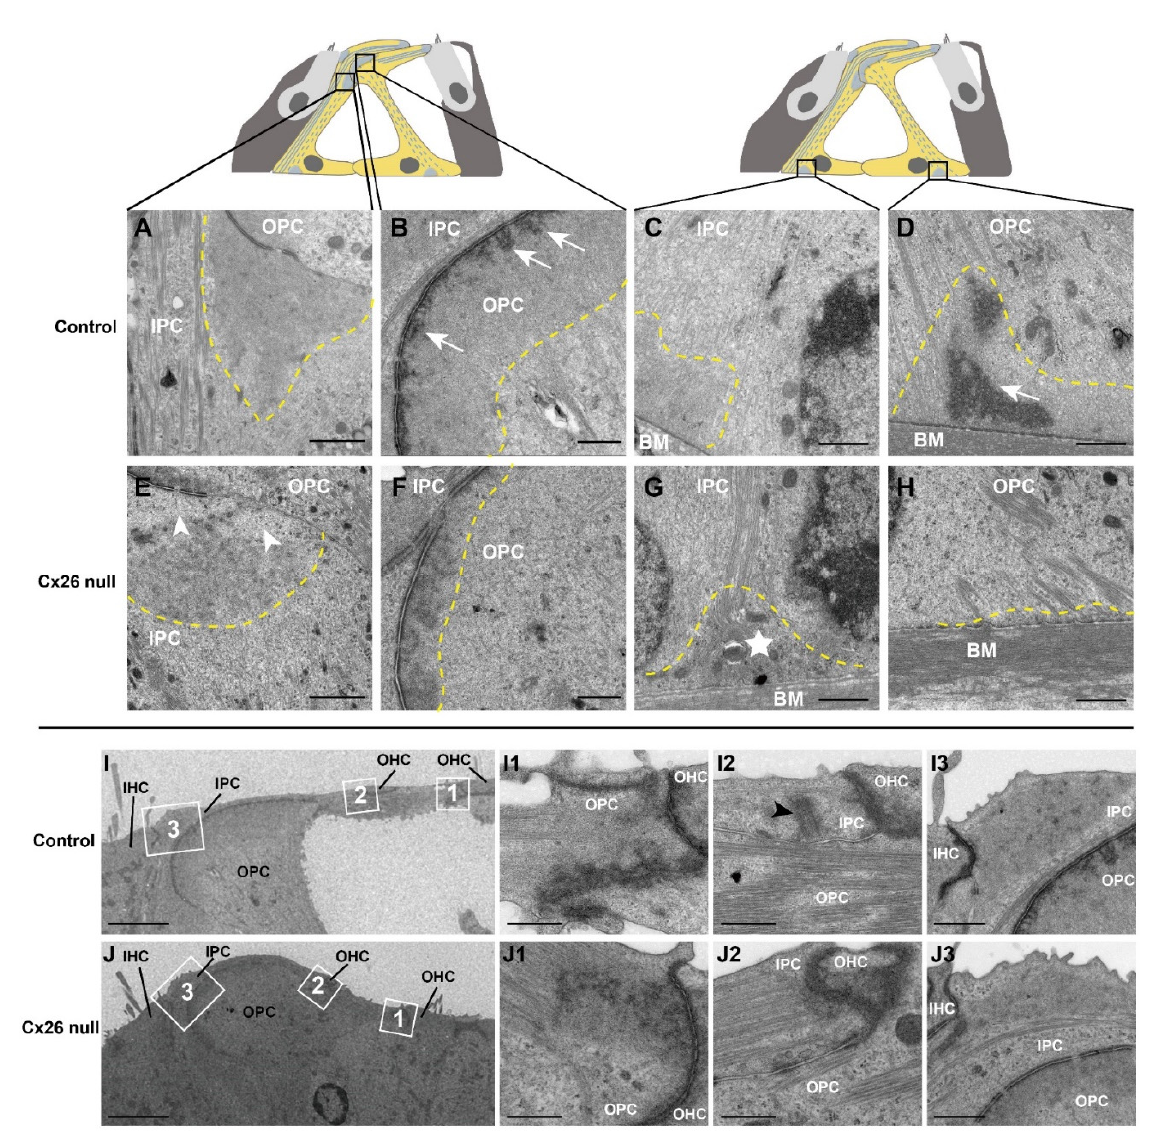
Figure 5. Ultrastructural changes of PCs’ non-centrosomal MTOCs in Cx26-null mice. ( A – H ) TEM longitudinal sections of PCs at P18. The assessed positions are displayed in the schematic diagrams (top). The SSSs at non-centrosomal MTOCs far from centrosome are indicated by broken yellow lines. Loose fibrous meshwork of SSSs was observed in Cx26-null group (broken yellow lines, E – H ). Absent fibrous materials of the medial SSS in the IPC are indicated by white arrowheads. Dense tufts of SSSs highlighted by white arrows were missing in Cx26-null group. Phagocytosis of the basal SSS is indicated by a white star. ( I , J ) TEM longitudinal sections show the ultrastructure at non-centrosomal MTOCs near centrosome at P18. (I1, I2, J1, J2) Magnification of positions 1 and 2 in ( I , J ), respectively, shows the ultrastructure of phalangeal non-centrosomal MTOCs; (I3, J3) Magnification of position 3 in ( I , J ), respectively, shows the ultrastructure of apical non-centrosomal MTOCs in IPCs. A centriole is indicated by a black arrowhead. SSS: surfoskelosome, P: postnatal, TEM: transmission